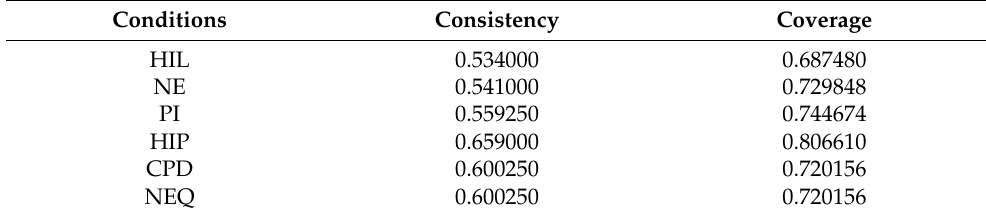
Table 2. The results of the single-factor necessity